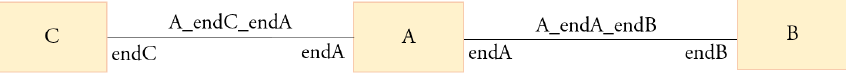
Figure 4. Examples of OMG naming